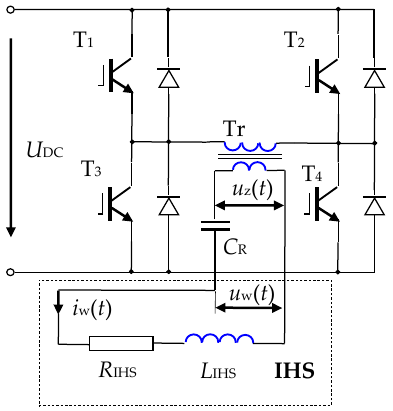
Figure 3. Diagram of the high-current part of a bridge-type voltage inverter with serial resonance cooperating with an induction heating system (IHS).